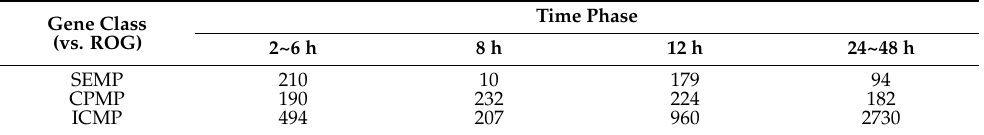
Table 3. Number of genes of each gene class in four different time phases. Gene Class (vs. ROG)